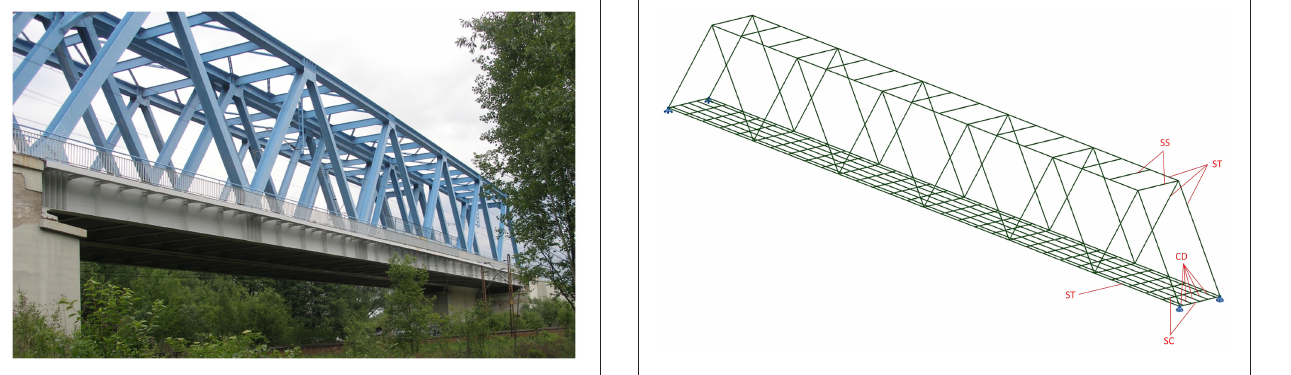
FIGURE 8 | Geometry of the numerical model of the bridge, marked the elements of bridge structure modeled with a 1-D beam elements: ST-element of steel truss, SS-steel strut beam, SC-steel cross beam, CD-element of reinforced concrete deck; (Olaszek et al., 2013) permission was granted by Waldemar Szaniec (author of the